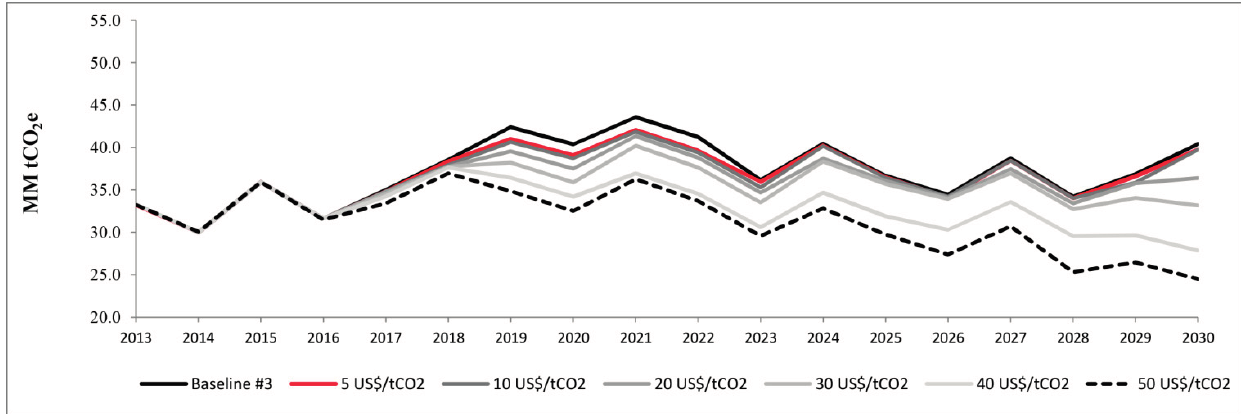
Figure 8. Emissions for baseline scenario #2 in comparison to different scenarios of carbon tax (MM = million).